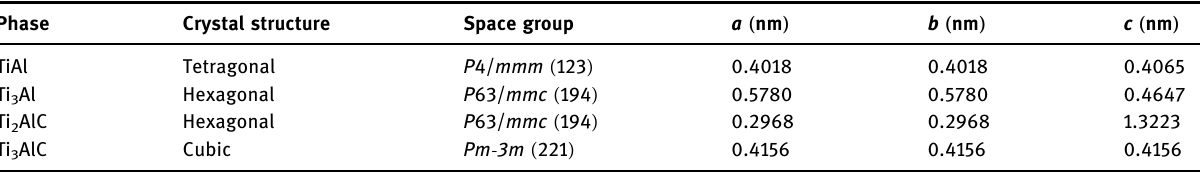
Table 1: The crystal structure and lattice parameters of TiAl, Ti 3 Al, Ti 2 AlC, and Ti 3 AlC